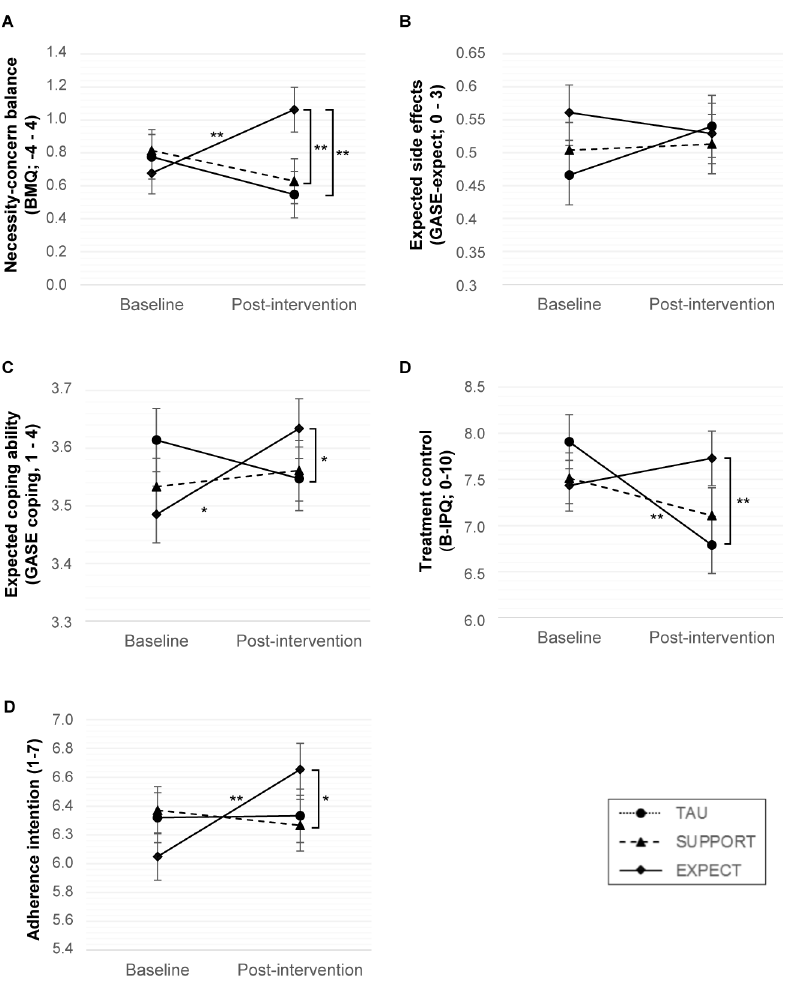
Note. Values shown are estimated marginal means (error bars: ± 1 standard error) from linear mixed models. TAU = treatment as usual, SUPPORT = supportive therapy, EXPECT = expectation management training. Numbers after scale names indicate the